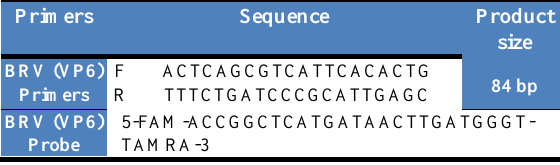
Table, 1: The primers and probe used in the study.